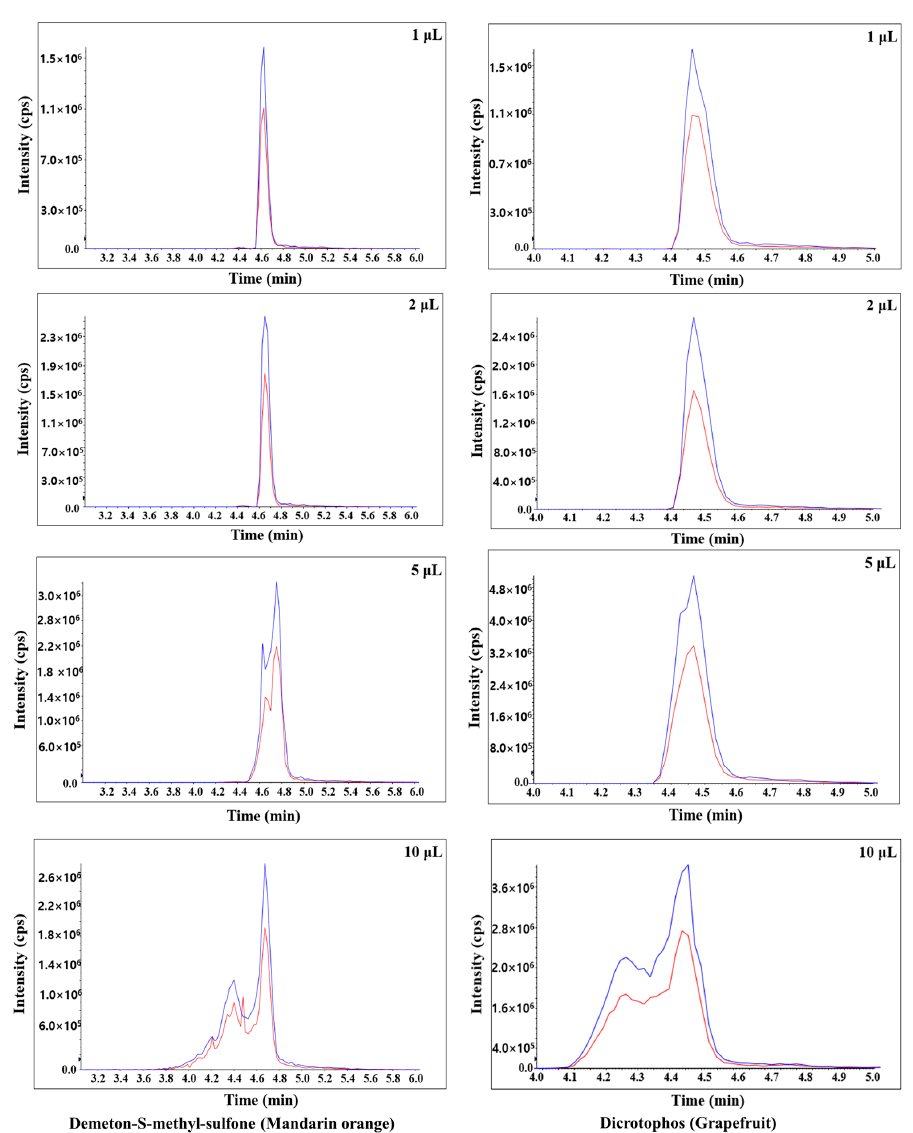
Figure 2. Typical chromatograms of demeton-S-methyl-sulfone and dicrotophos in mandarin orange and grapefruit, respectively, obtained using different injection volumes (1, 2, 5, and 10 μ L). The blue and red lines were quantitative and qualitative ions, respectively.